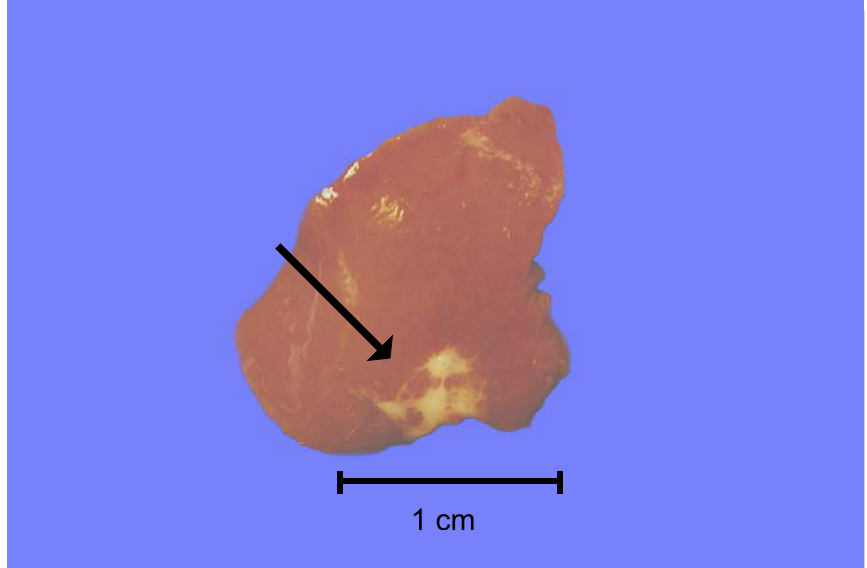
1 FIGURA 6 – Aspecto macroscópico do fígado de coelho decorridos 14 dias da injeção de solução de ácido acético 5%. Área cicatricial (seta)